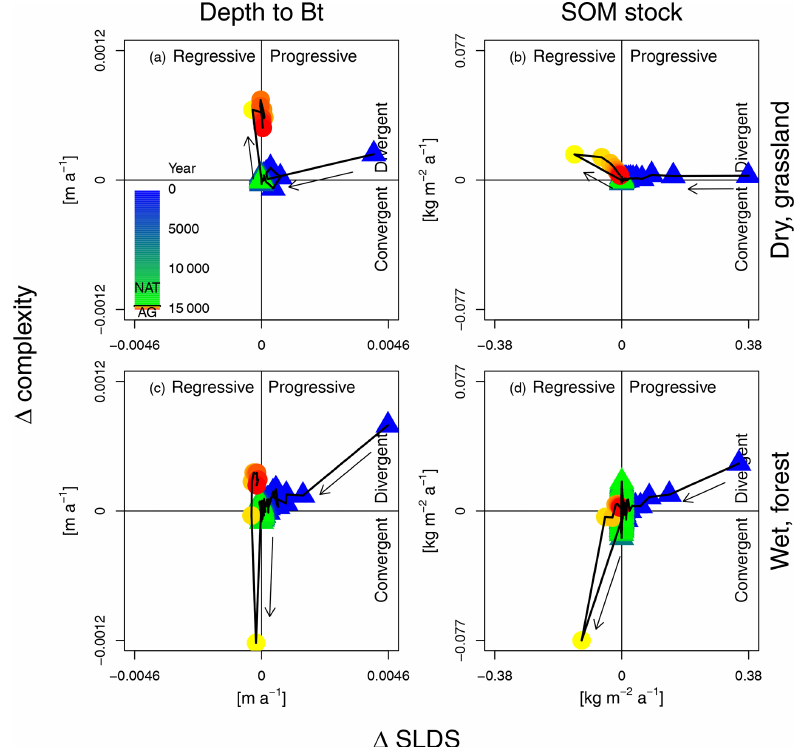
Figure 4. Changes in SLDS ( x axis) and complexity ( y axis) for depth to Bt horizons (a, c) and SOM stocks (b, d) for both rainfall scenarios ( dry: a, b ; wet: c, d) . The colors of the symbols indicate the year. The symbols themselves indicate the land use (triangles: natural, years 0–14500, blue to green colors; circles: agricultural, years 14500–15000, yellow to red colors). The time step (cid:49)t over which the evolutionary pathways are calculated is 50 years for both land